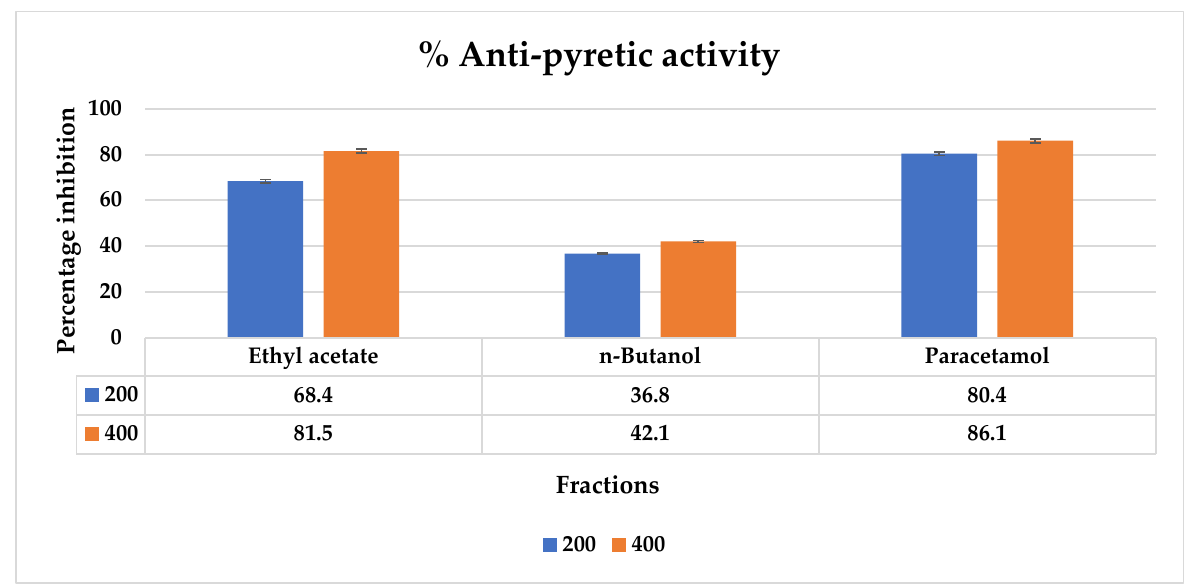
Figure 18. The antipyretic activity of fractions of T. vulgaris fractions in vivo.